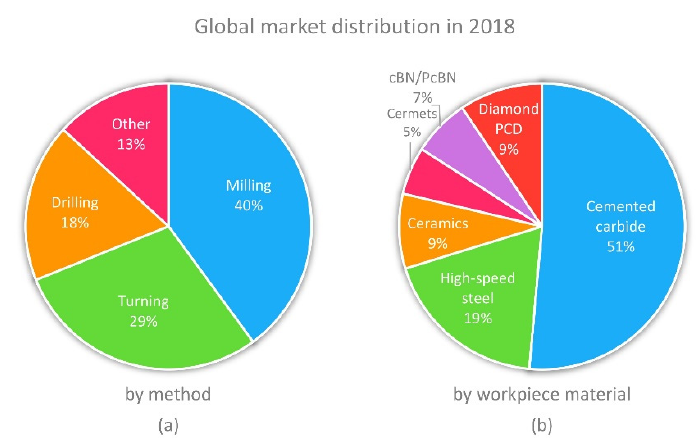
Figure 1. Cutting tool global market distribution by cutting technology ( a ) and by workpiece material ( b ) as presented by Dedalus Consulting. Data taken from [7].